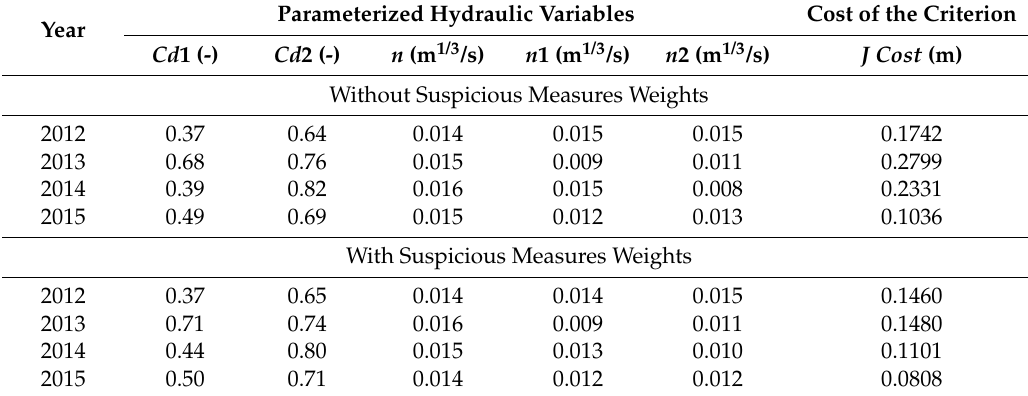
Table 3. The values of the five parameterized variables and the cost of the criterion obtained from the optimization process: Without (above) and with the weights of suspicious measures